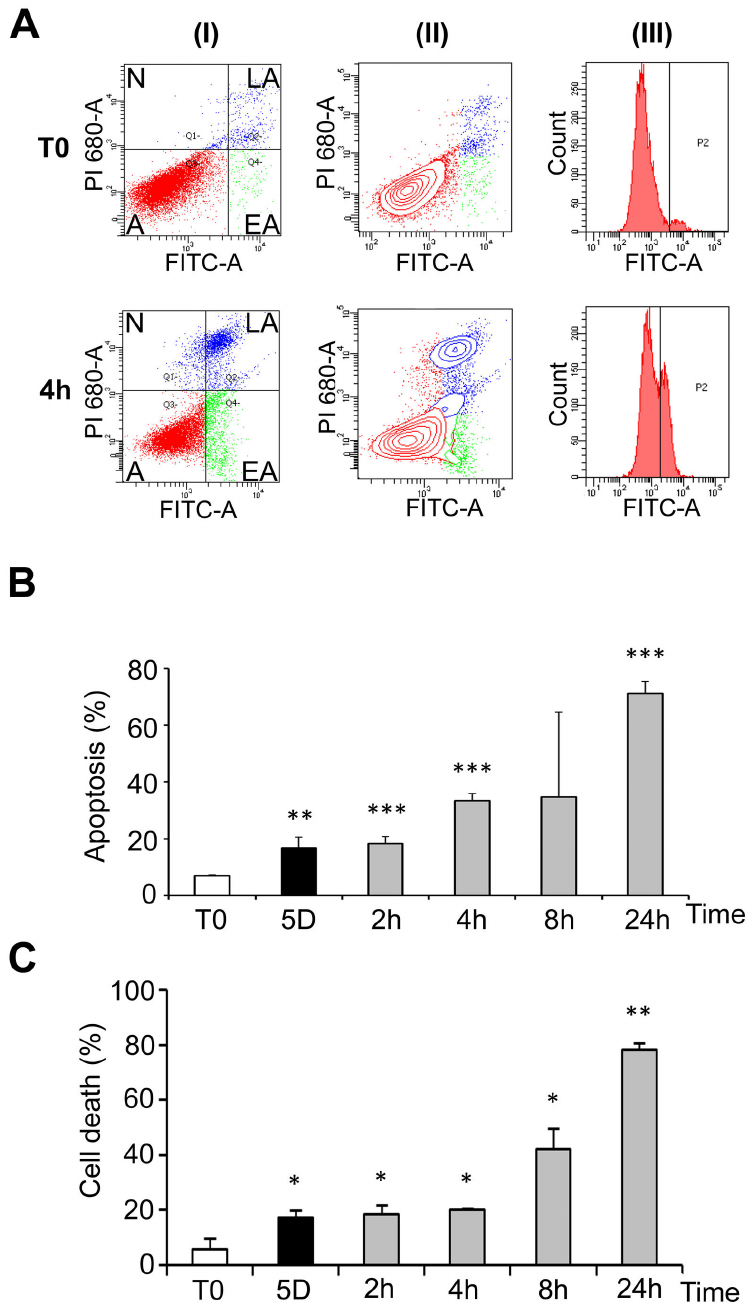
Figure 4. Cold shock and rewarming affect cell viability. WI26 cells were cultured at 25°C for 5 days and then warmed-up at 37°C for 2 to 24h. Cells kept at 37°C were used as control (T0). FACS analysis was performed after labeling with FITC-annexin V (FITC-A, X-axes) and propidium iodide (PI, Y-axes). 12.000 to 18.000 events were collected for each experiment. (A) Example of dots graphs (I), contour graphs (II) and annexin V curves (III) of control cells and cells maintained 5 days at 25°C and then warmed- up at 37°C for 4h (4h). Alive cells [A] (double negative staining), cells in early apoptosis [EA] (annexin V positive, PI negative), in late apoptosis [LA] (double positive) and necrotic [N] (annexin V negative, PI positive) are indicated on the graphs. Annexin V curves (III) were used to define the gating allowing to discriminate the populations. (B) Percentage of apoptotic cells as measured by FACS analysis. Cells were cultured at 37°C (T0) or 25°C for 5 days and subsequent warming-up at 37°C for 2 to 24h. (C) Percentage of dead cells as measured by trypan blue exclusion assay. Cells were cultured in duplicate for 5 days at 25°C and then rewarmed for 2 to 24h at 37°C. doi: 10.1371/journal.pone.0069687.g004 PLOS ONE |